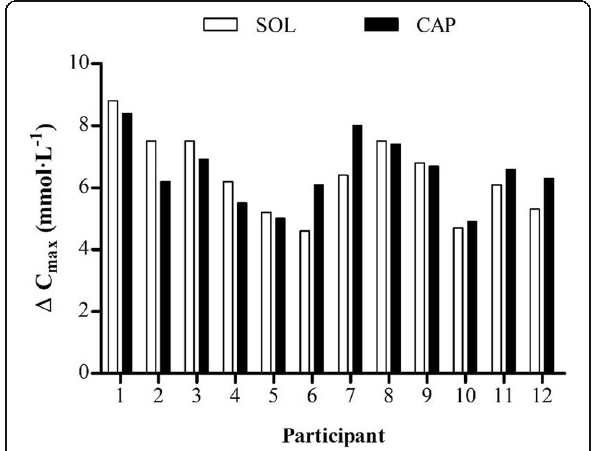
Fig. 3 Individual changes in blood bicarbonate concentration between conditions (SOL and